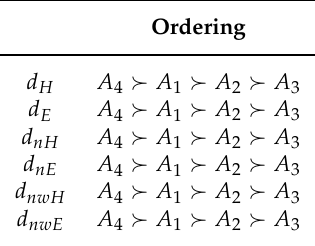
Table 3. Ordering of the